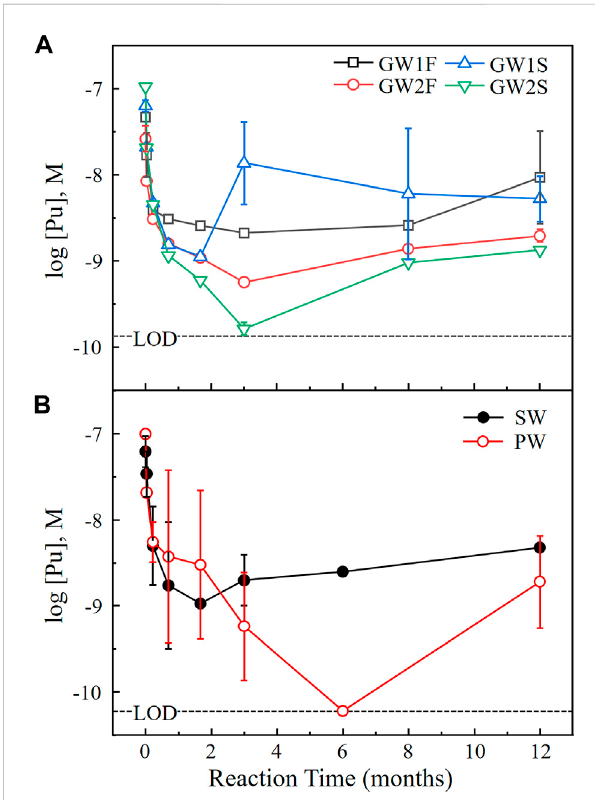
FIGURE 2 Dissolution behaviors of PuO 2 (cr) at 25 ° C in (A) groundwater and (B) seawater and concrete porewater (set A) as a function of the reaction time. The dashed lines indicate the LOD by LSC under the given experimental